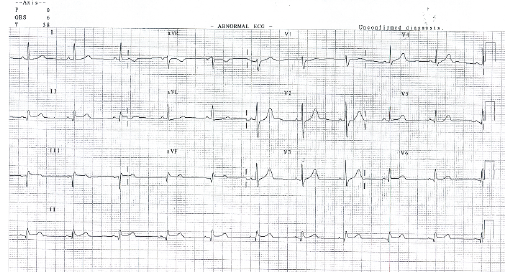
Figure 2: 12-lead ECG after thrombolysis with tenecteplase. There is ST segment resolution with small q wave in leads II and AVF.